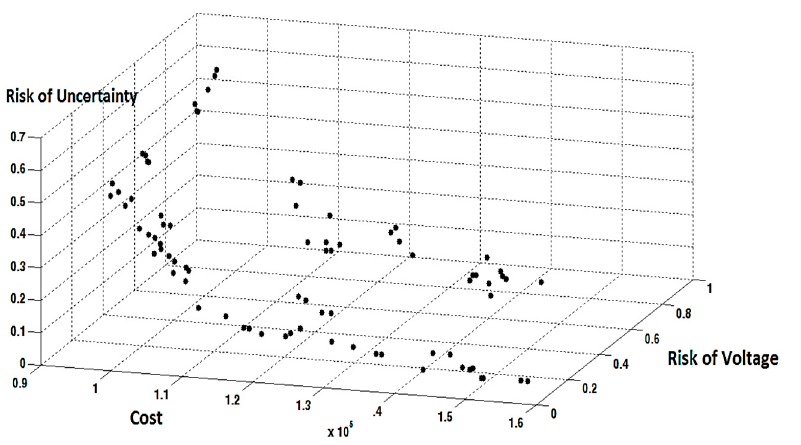
Figure 14. Pareto response space in locating fixed capacitors in the studied network.